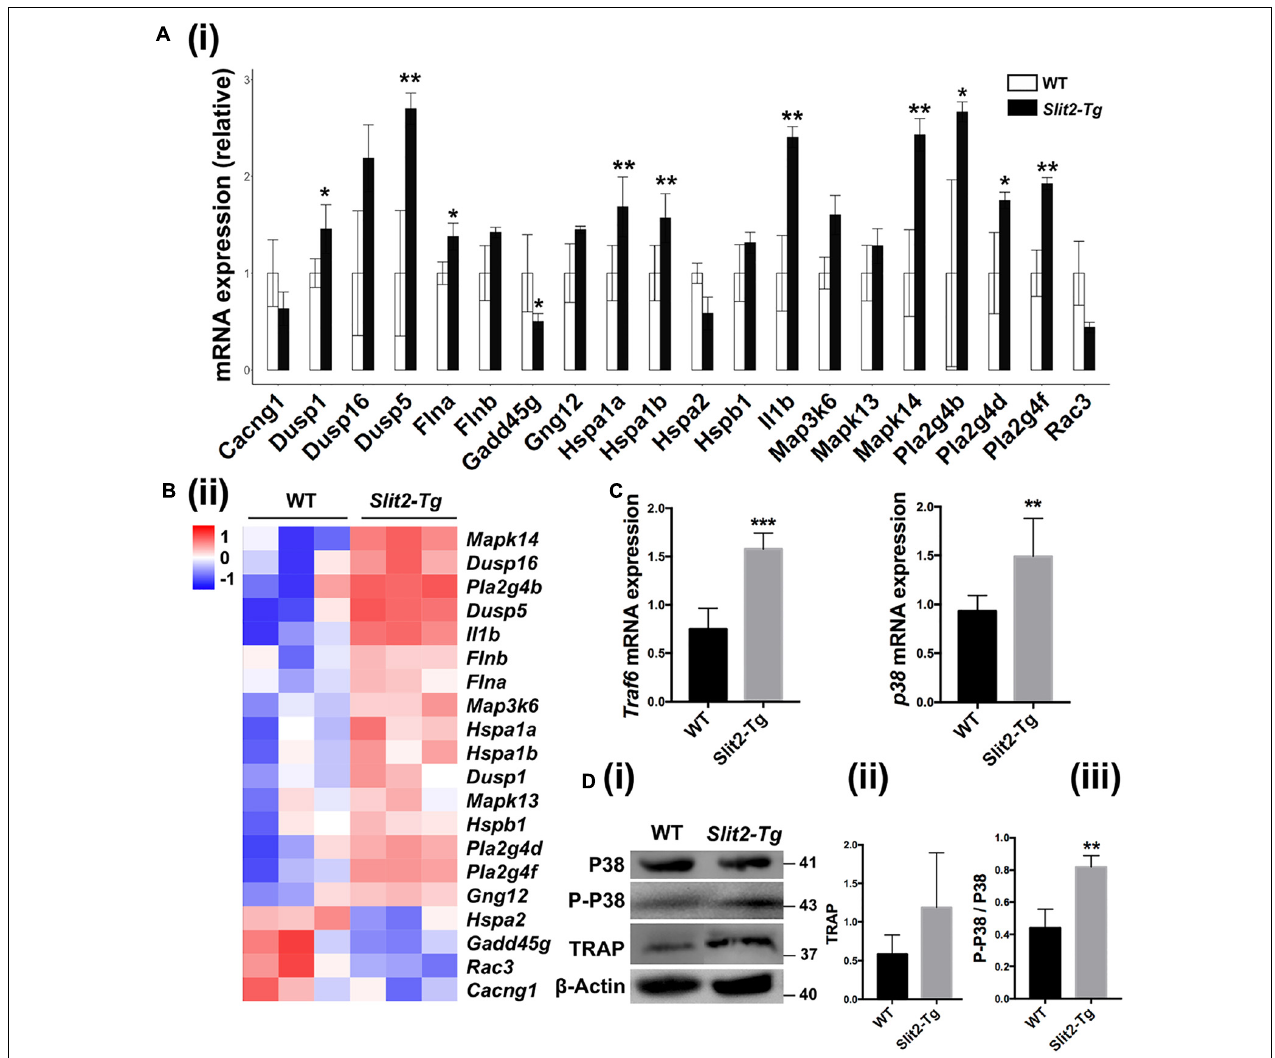
FIGURE 7 | SLIT2 overexpression activates MAPK signaling pathway in periodontitis milieu. (A (i)) Relative mRNA expression ( n = 3), and (A (ii)) Heat map of the differential expression pattern of MAPK signaling pathway-related genes in PAPT analyzed by RNA sequencing. Relative mRNA expression of (B) Traf6 , and (C) p38 in PAPT analyzed by RT-qPCR ( n = 6). (D (i)) Representative western blot images of MAPK signaling related proteins. (D (ii), (iii)) Quantitative analysis of TRAP and P-P38 ( n = 4). Data are presented as mean ± SD. The significant difference among the groups, * P < 0.05, ** P < 0.01, *** P <